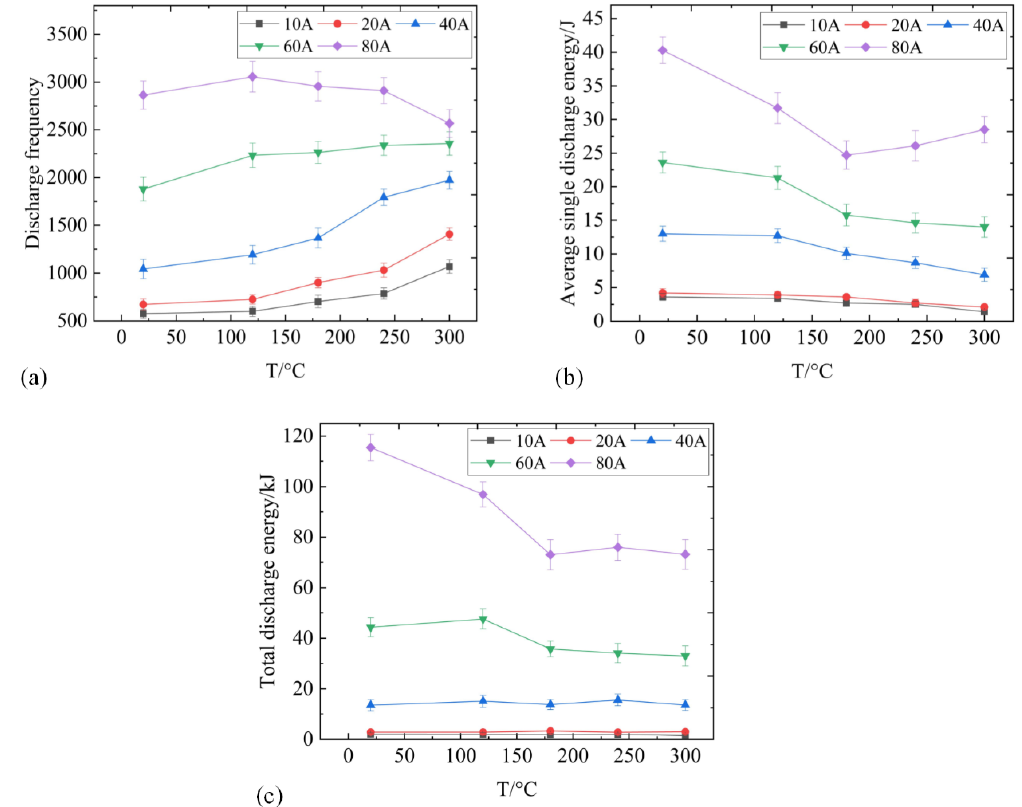
Figure 5. Effect of temperature on the arc discharge of the C-Cu contacts: ( a ) discharge frequency; ( b ) average single discharge energy; and ( c ) total discharge energy.